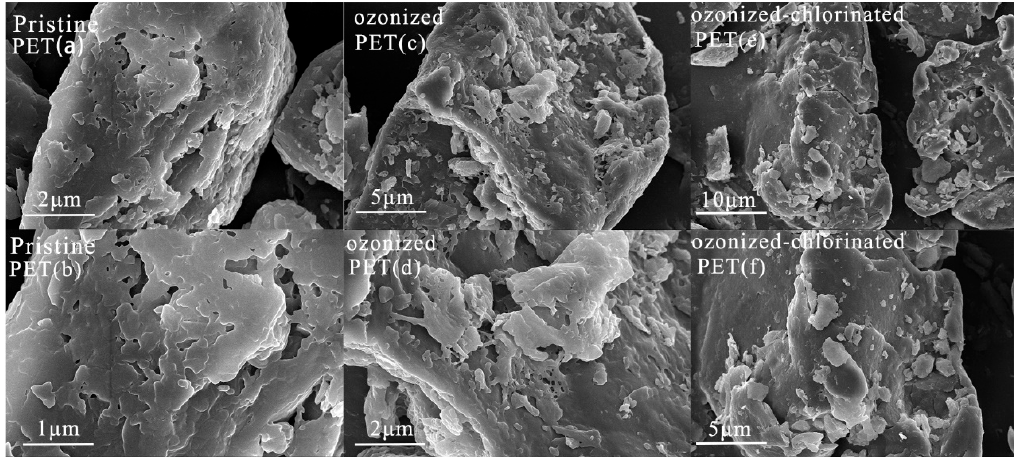
Figure 1. SEM micrograph of pristine PET ( a , b ), ozonized PET ( c , d ), ozonized-chlorinated PET ( e , f ).